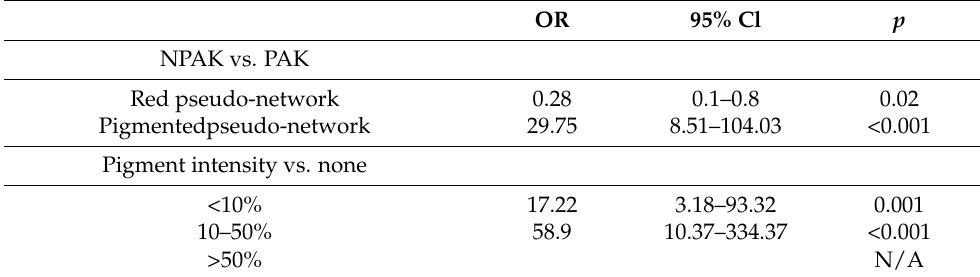
Table 4. Logistic regression analysis of statistically significant dermoscopic criteria. OR 95% Cl p NPAK vs. PAK Red pseudo-network 0.28 0.1–0.8 0.02 Pigmentedpseudo-network 29.75 8.51–104.03 <0.001 Pigment intensity vs. none <10% 17.22 3.18–93.32 0.001 10–50% 58.9 10.37–334.37 <0.001